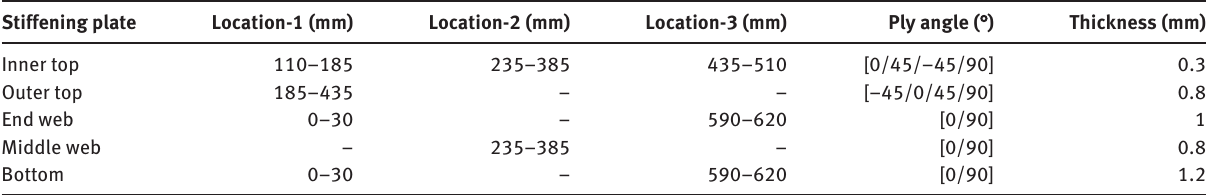
Table 4: Stiffening plate location and its ply mode of different components in box girder. Stiffening